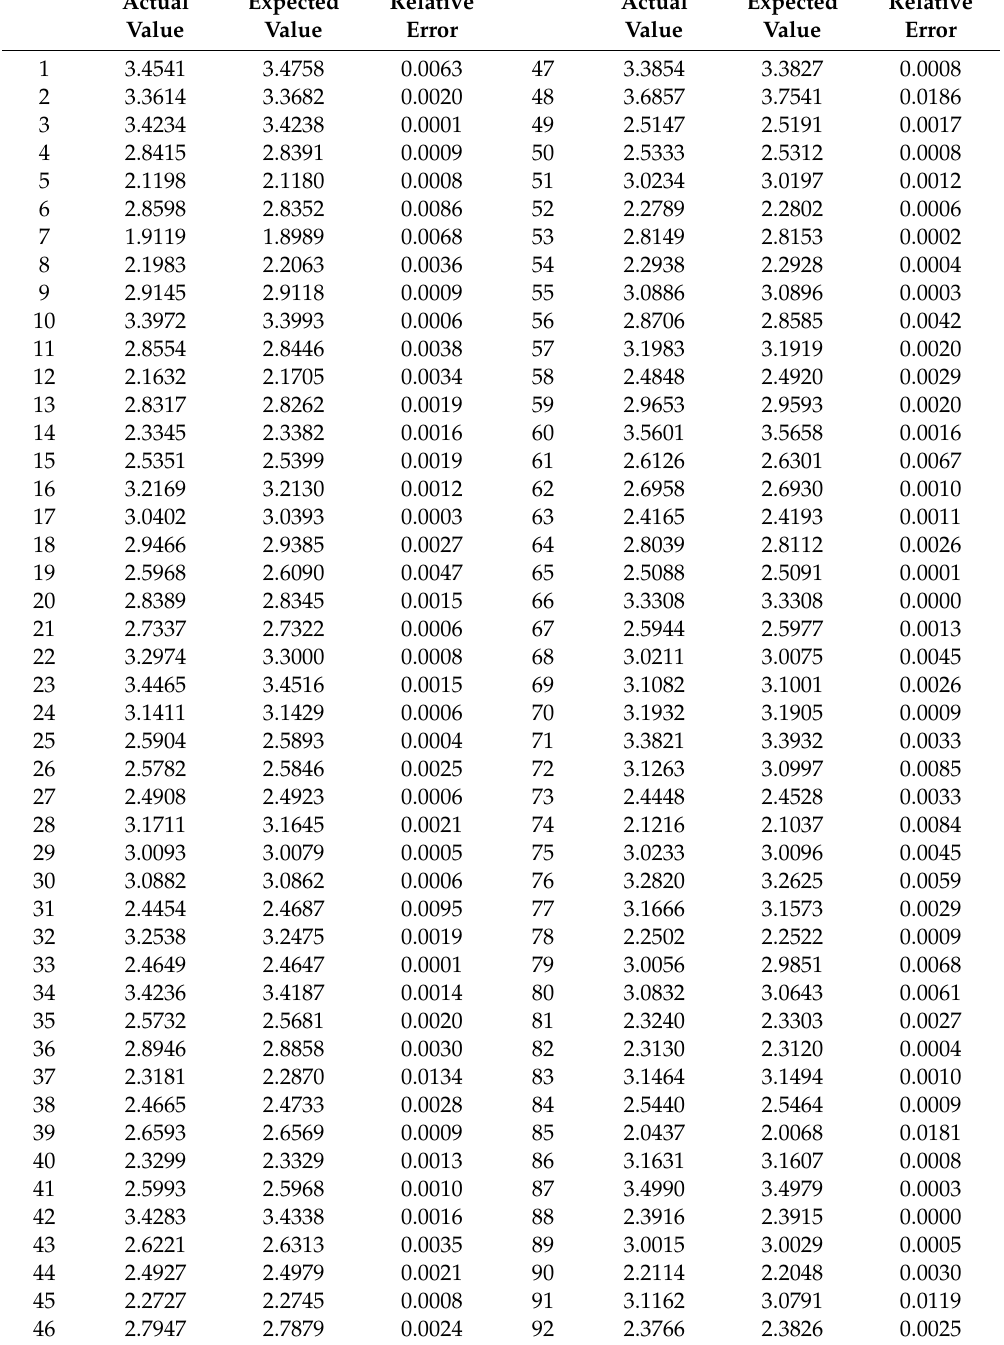
Table A2. Network output results of Wannina